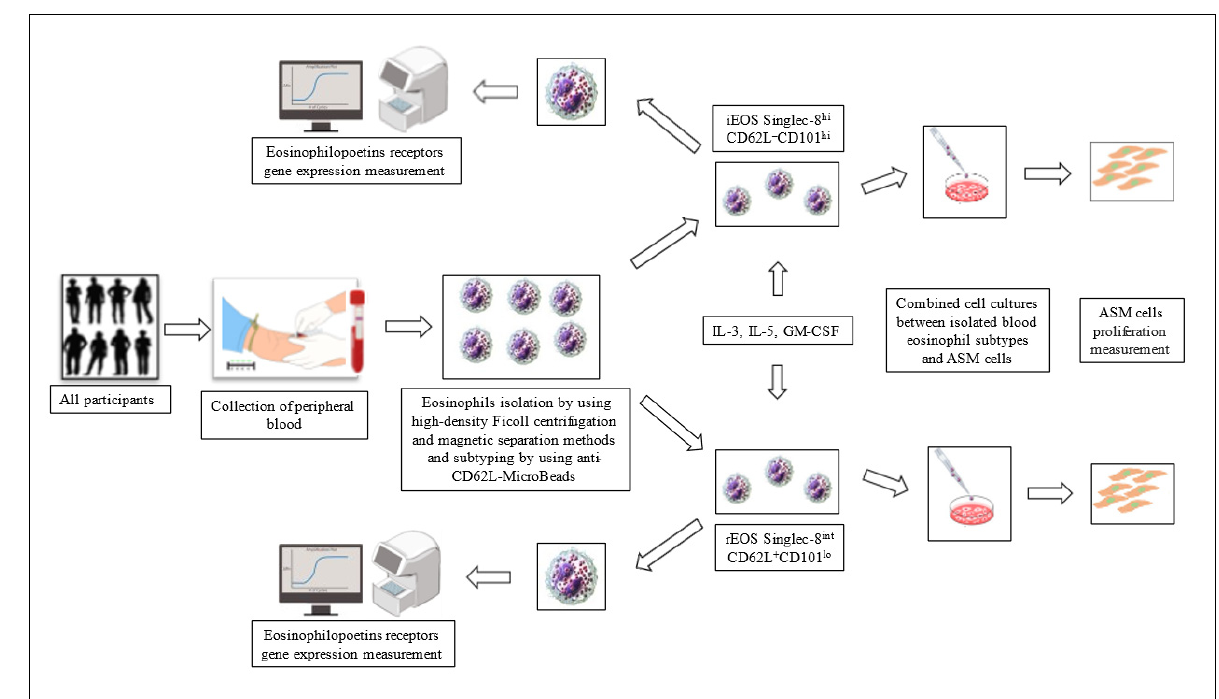
Figure 1. Graphical overview of the study design. ASM—airway smooth muscle; IL—interleukin; GM-CSF—granulocyte-macrophage colony-stimulating factor; CD—cluster of differentiation.